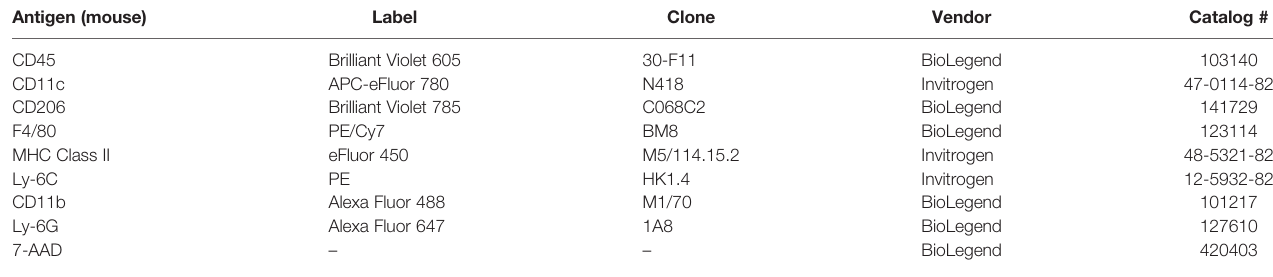
TABLE 2 | List of antibodies used for immunophenotyping. Antigen (mouse)